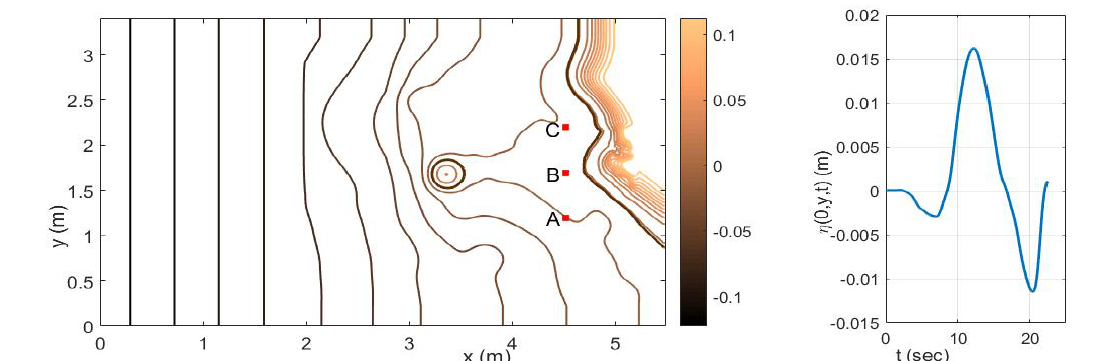
Figure 11. ( Left ) Topographic profile and contour plot of Monai Valley. Point A, B, and C are the observation points. ( Right ) Incident waves